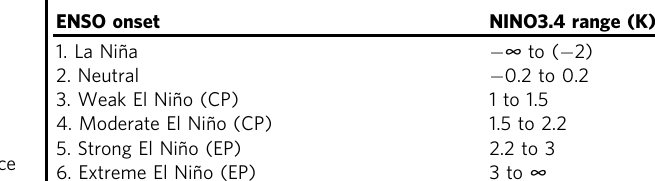
Table 2 The ranges of the OND Niño3.4 used to generate control initial condition (IC) 10-member ensemble simulations for different ENSO